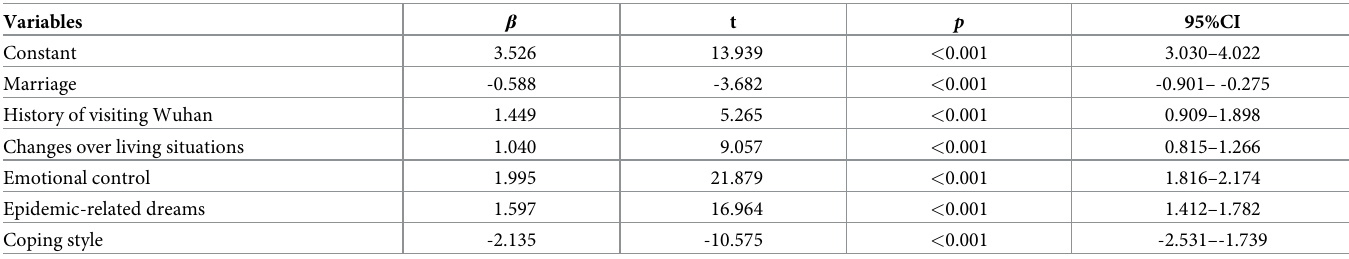
Table 4. Stepwise multiple linear regression analysis for psychological distress (K6 scores) of participants (n = 1599).